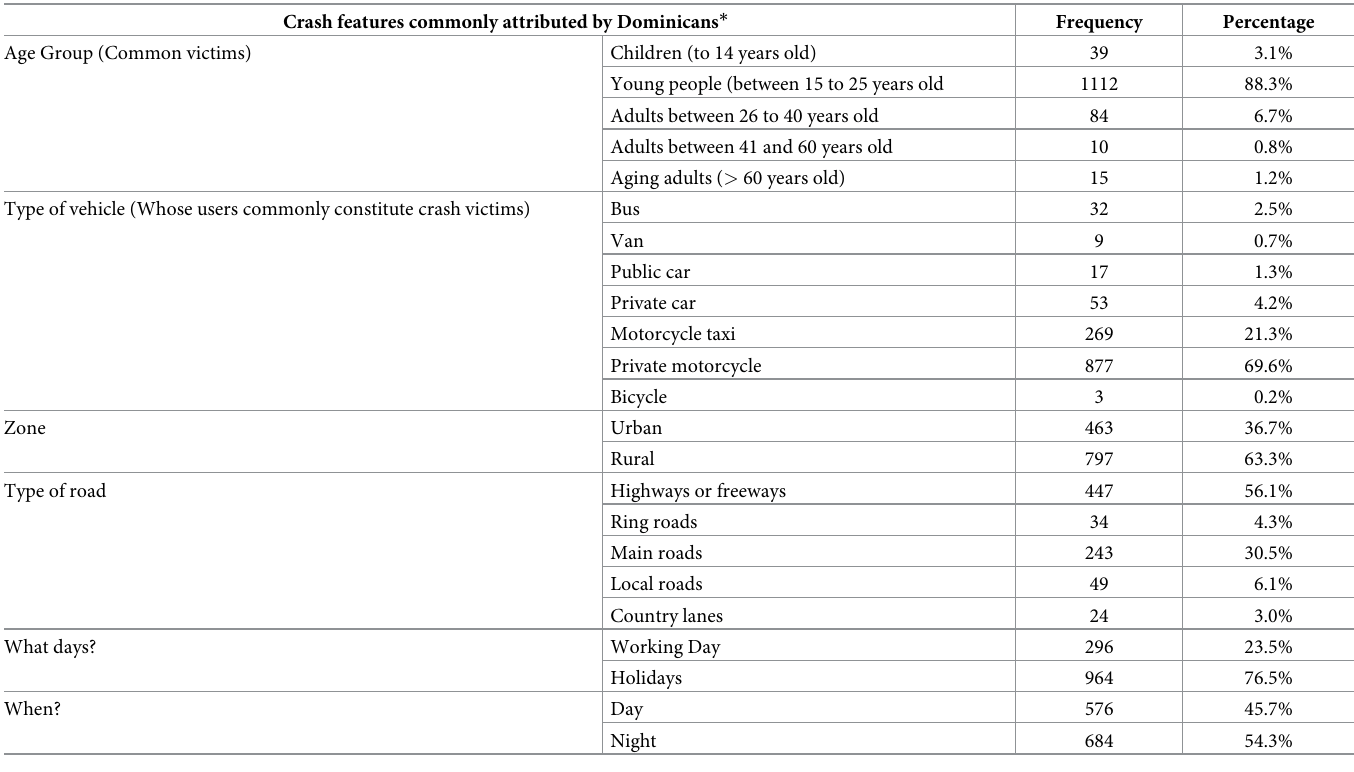
Table 3. Typical crash-related beliefs (hypothesized crash configurations) in the Dominican Republic. Crash features commonly attributed by Dominicans